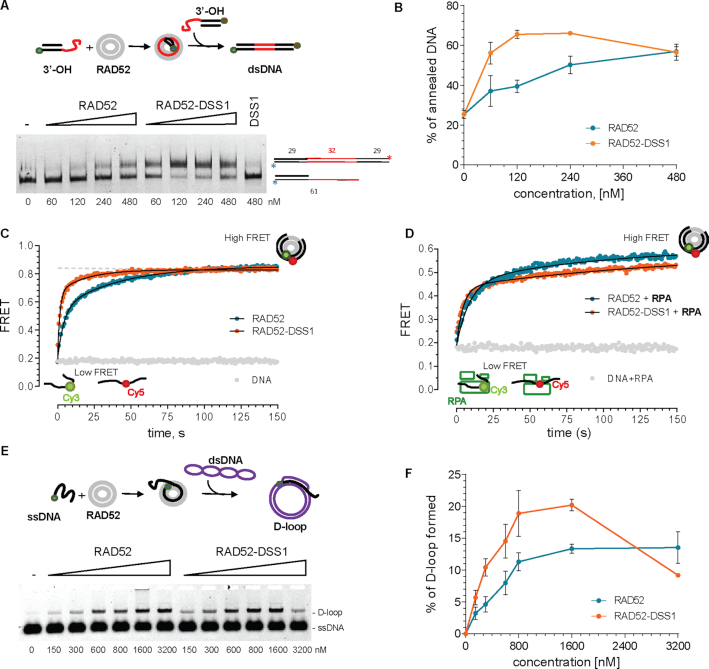
RAD52 annealing and homology search are stimulated by DSS1. (A) Gel-based SSA assay using complementary fluorescent 3′-OH substrates in the presence of indicated concentration of RAD52 or RAD52–DSS1 complex. The position of substrate and product of annealing reaction are indicated. (B) Quantification of the annealing reactions from three independent experiments. The mean values ± SD were plotted. (C) FRET based ssDNA annealing experiments of complementary 28-mer oligonucleotides labelled with Cy3 and Cy5 dyes, respectively in the presence of RAD52 (8 nM, blue) and RAD52-DSS1 complex (8 nM-40 nM, orange). (D) FRET based ssDNA annealing experiment of complementary 28-mer oligonucleotides labelled with Cy3 and Cy5 dyes in the presence of RPA (2 nM), respectively in the presence of stoichiometric amounts of RAD52-RPA (8–2 nM, blue) and RAD52-RPA-DSS1 (8–2–40 nM, orange) complex. These data are fit to a double exponential (solid lines). (E) Scheme of in vitro D-loop reaction and representative agarose gel showing the formation of D-loop using indicated amounts of RAD52 or RAD52–DSS1. (F) Quantification of the D-loop reaction from three independent experiments. The mean values ± SD from were plotted.